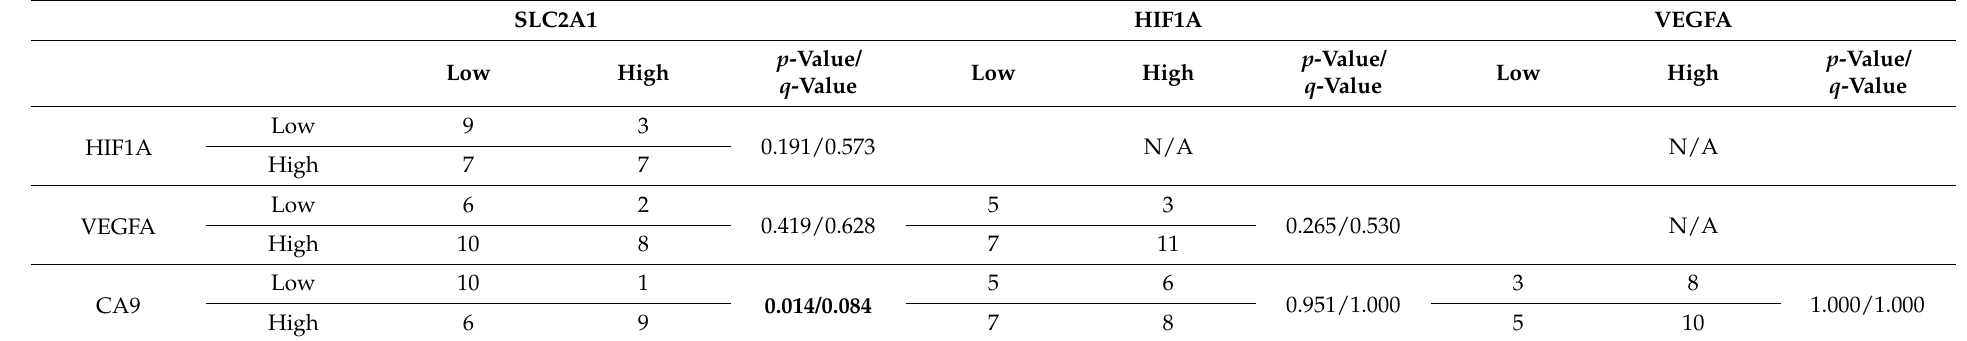
p -Value/ q -Value